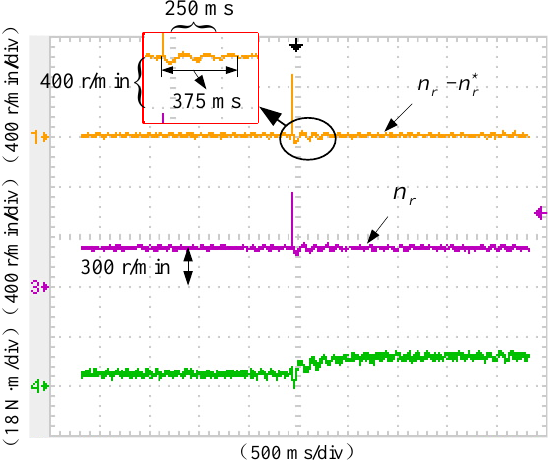
Figure 22. Experimental results of DTC ( P = 20, I = 0.8).